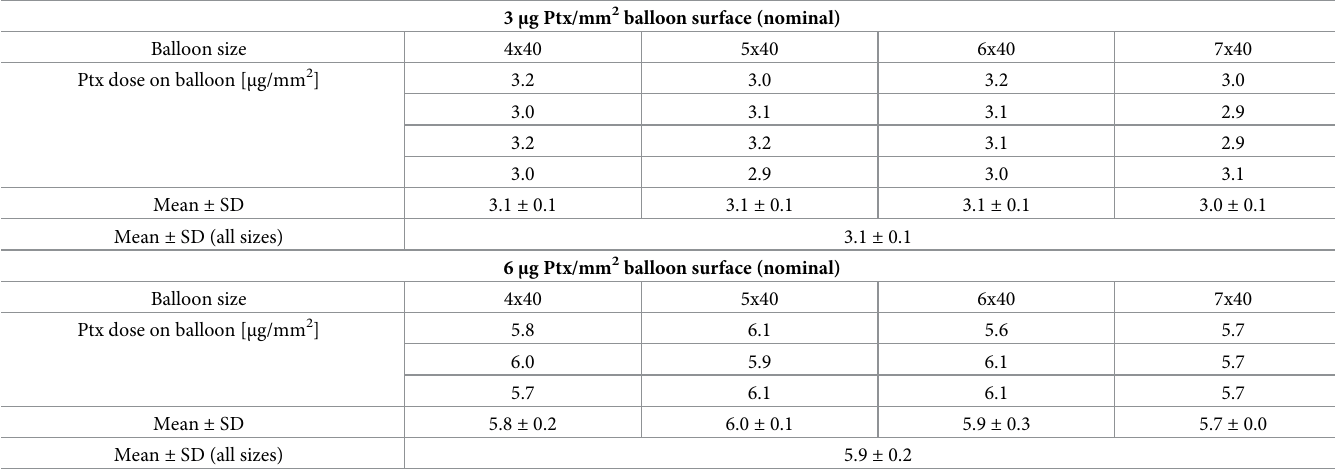
Table 1. Ptx doses on balloons coated with single dose or double dose.